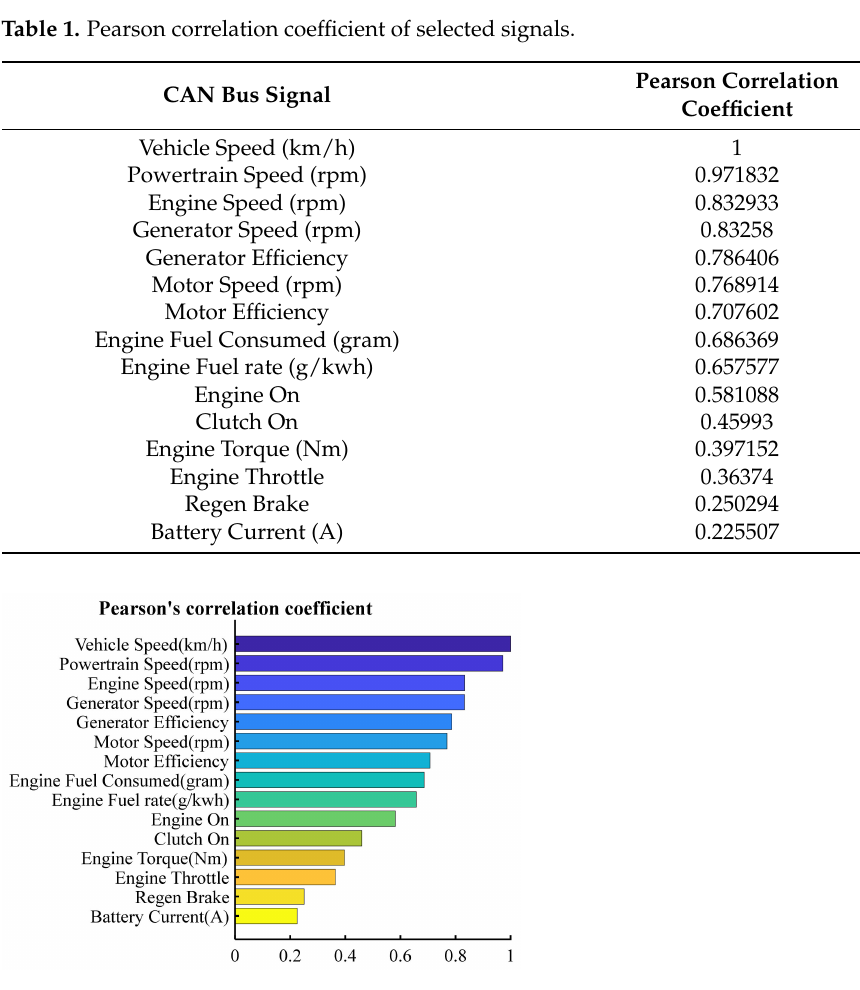
Figure 2. The illustration of Pearson correlation